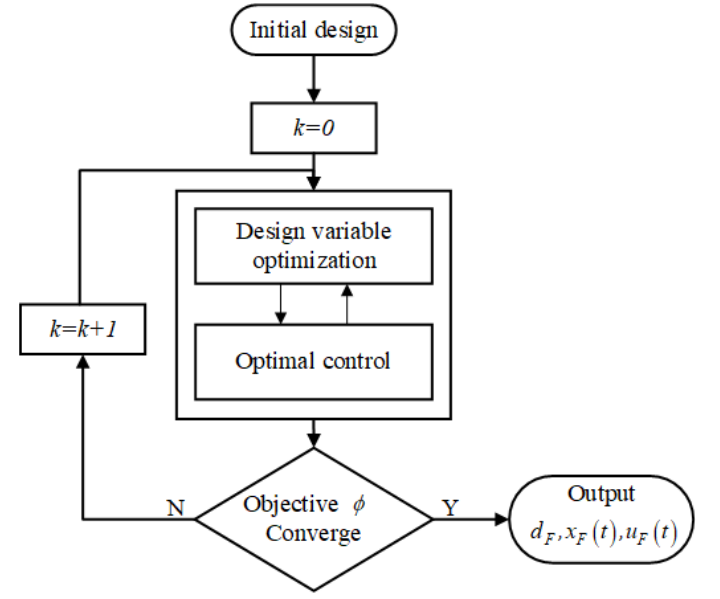
Figure 1. The algorithm flow chart of MDSDO. 127